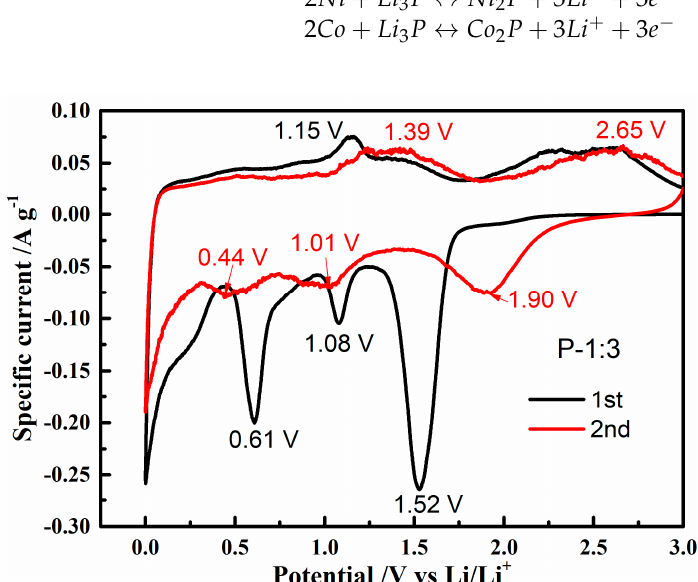
Figure 8. Cyclic voltammetry (CV) curves of Ni-Co-P sample with 1:3 ratio.